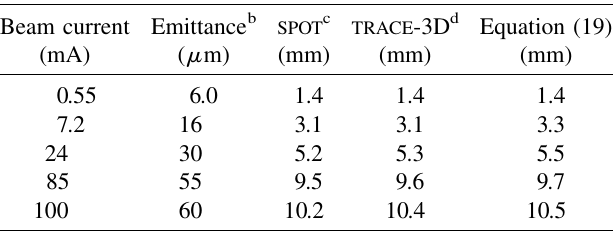
TABLE II. 2RMS average beam radius in a unit FODO cell of (cid:5) 72 : 92 (cid:12) . a UMER for 10 keV, (cid:5) 0 Beam current Emittance b SPOT c TRACE -3D d Equation (19)